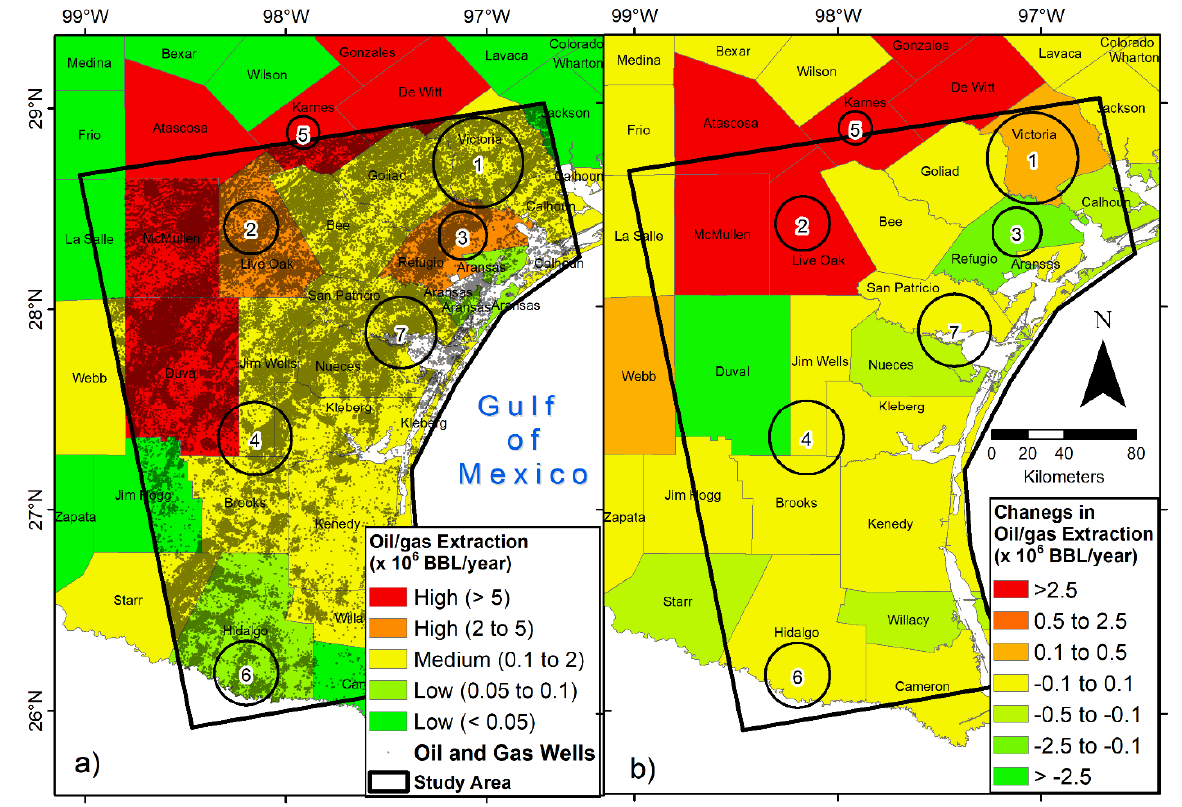
Figure 4. ( a ) Historical hydrocarbon extraction averaged by county during the period from 2000 to 2015. Oil/gas well locations are represented by black translucent dots. ( b ) Difference in oil/gas extraction rates between the study period (2016–2019) and the historical period (2000–2015).